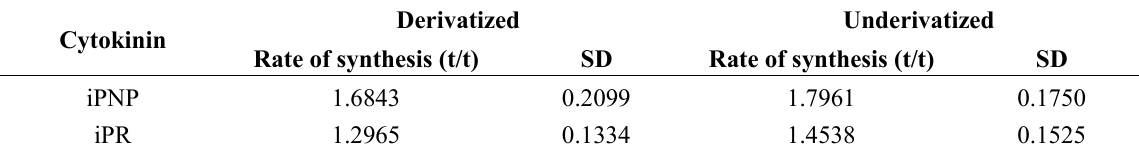
Table 4. The relative biosynthetic rate (t/t) of iP-type nucleotides (iPNP) and isopentenyladenosine (iPR) isolated from Arabisopsis seedlings 6h after chemical induction of AtIPT8